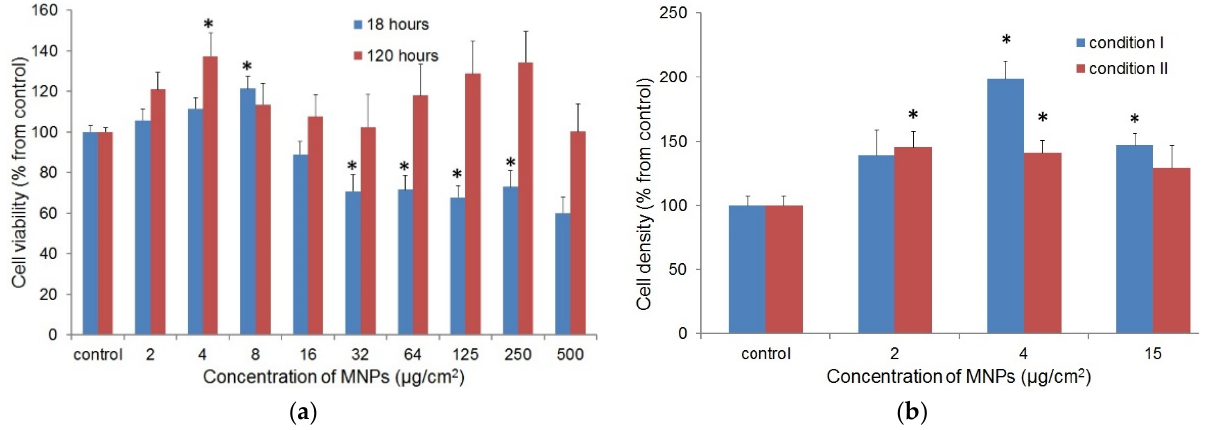
Figure 5. ( a ) The metabolic activity of human skin fibroblasts after short- (blue columns) and long- term (red columns) incubation with MNPs in various concentrations (MTT test). The data presented are normalized to optical density (OD) in control without MNPs (accepted for 100%). Values that are statistically different from control ( p < 0.05) are indicated by asterisks. ( b ) Proliferation of fibroblasts in the presence of MNPs. The cells were seeded with uptaken nanoparticles (condition I) or MNPs were added to growth medium after fibroblasts seeding (condition II). The data presented are normalized to cell monolayer density (cells/cm 2 ) in control without MNPs (accepted for 100%). Values that are statistically significant from control ( p < 0.05) are indicated by asterisks.